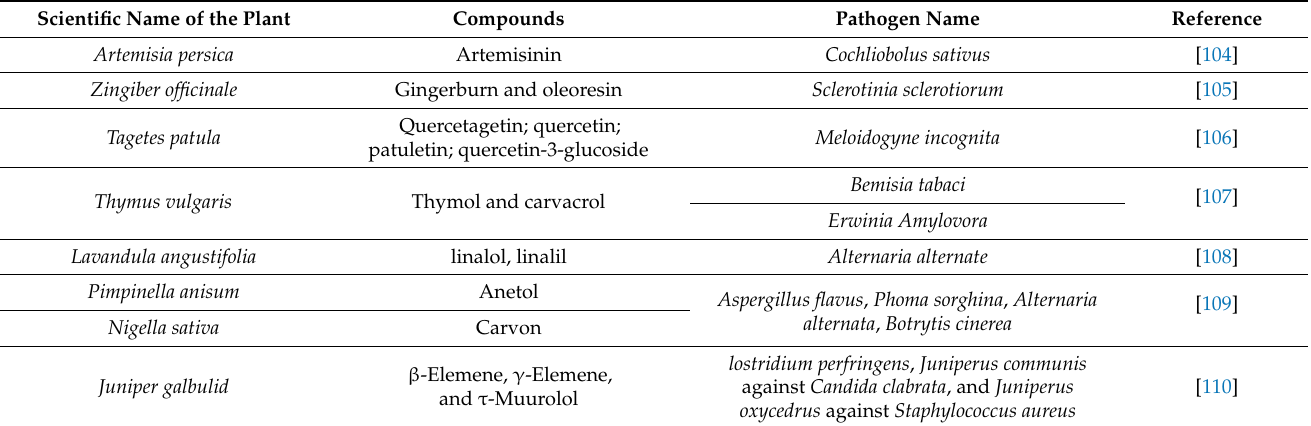
Table 4. Some medicinal plants with anti-pathogenic properties that are used in the agricultural